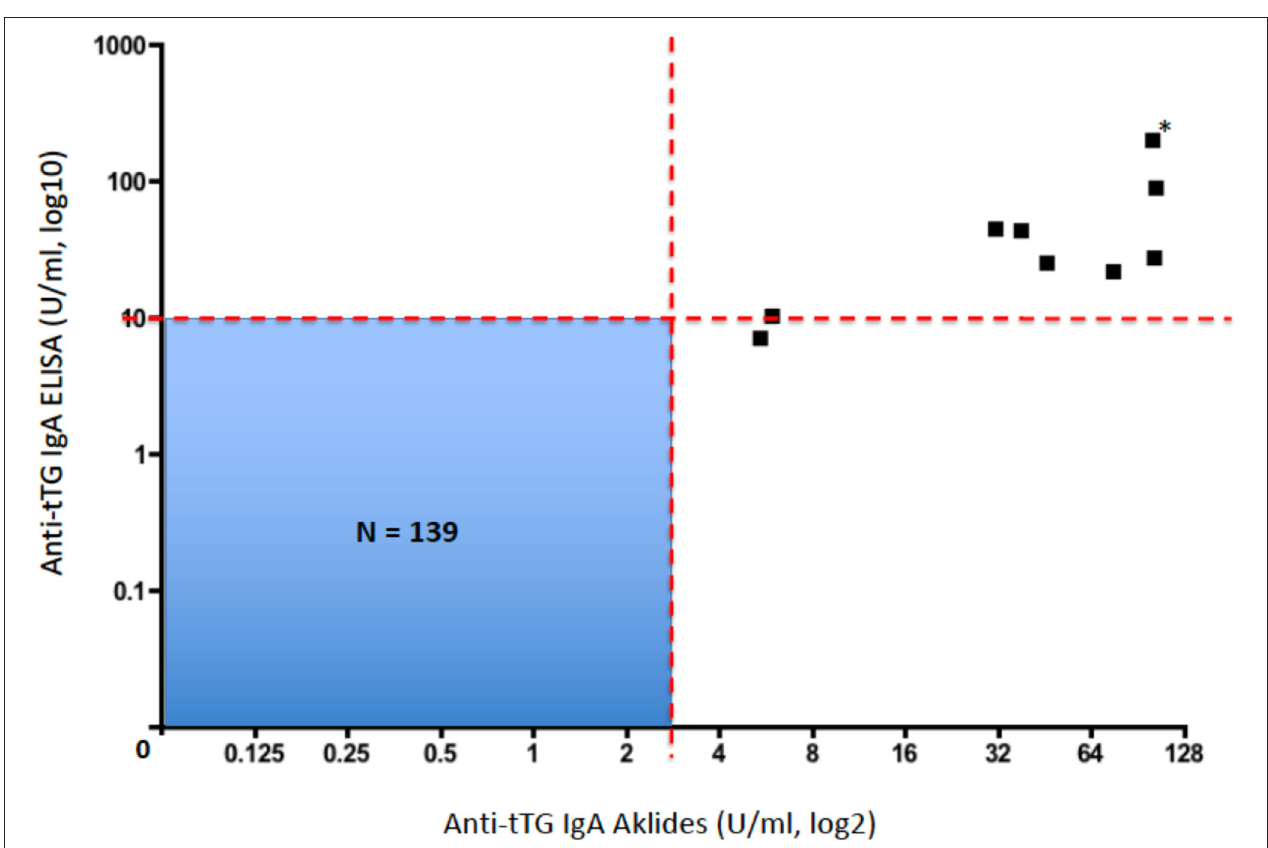
FIGURE 1 | Plot correlating anti-tTG IgA levels by CytoBead CeliAK immunoassay and anti-tTG IgA levels by ELISA (*this black square corresponds to two patients with identical values; N , total number of patients included in this blue quadrant; red dashed line, respective cutoff values for each assay).